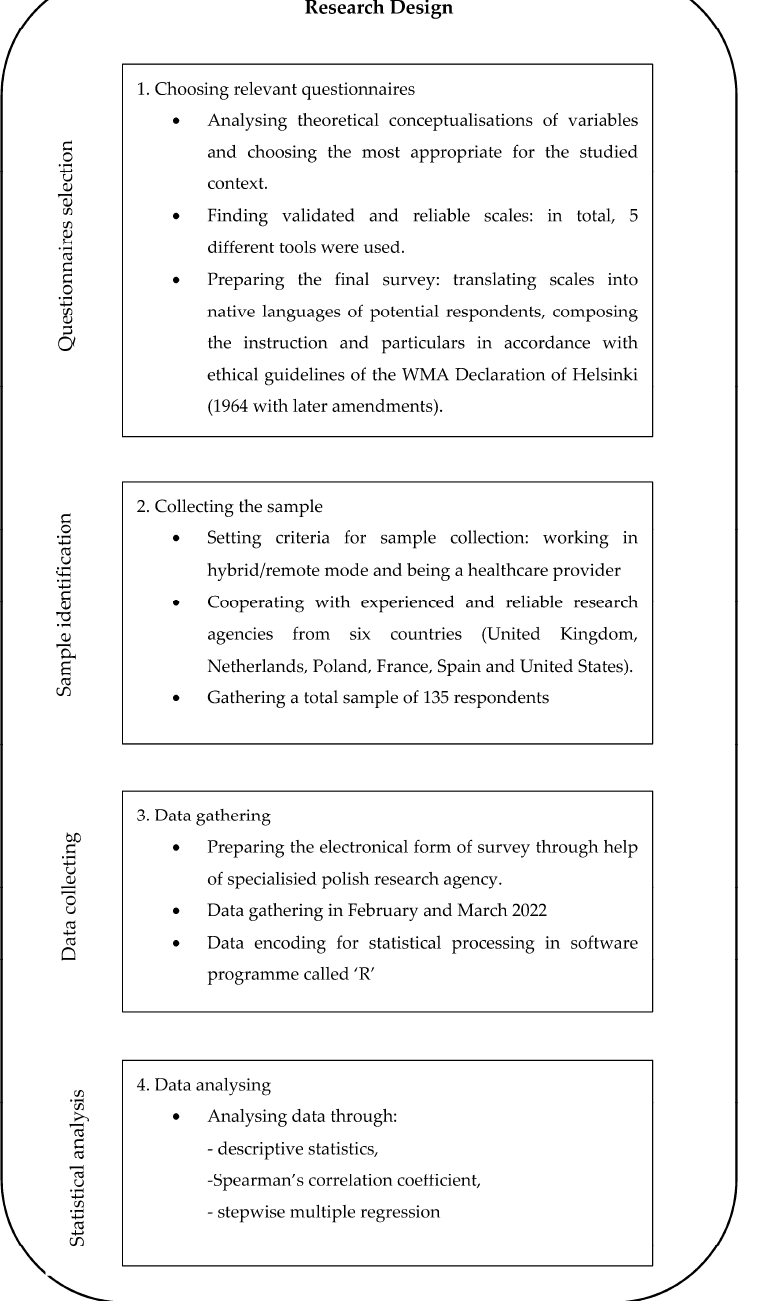
Figure 2. Research design of the current